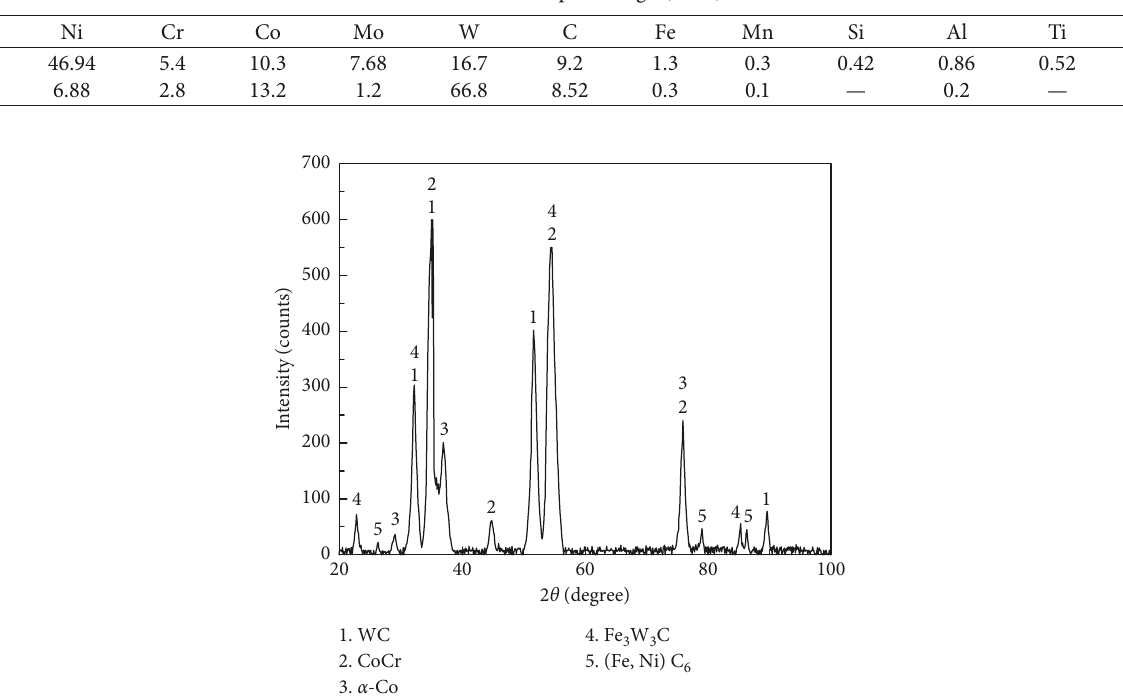
Figure 6: SEM diagram of cross section of WC-CoCr coating of electron beam cladding; 1: area 1; 2: area 2. Table 8: Element percentage (wt.%).